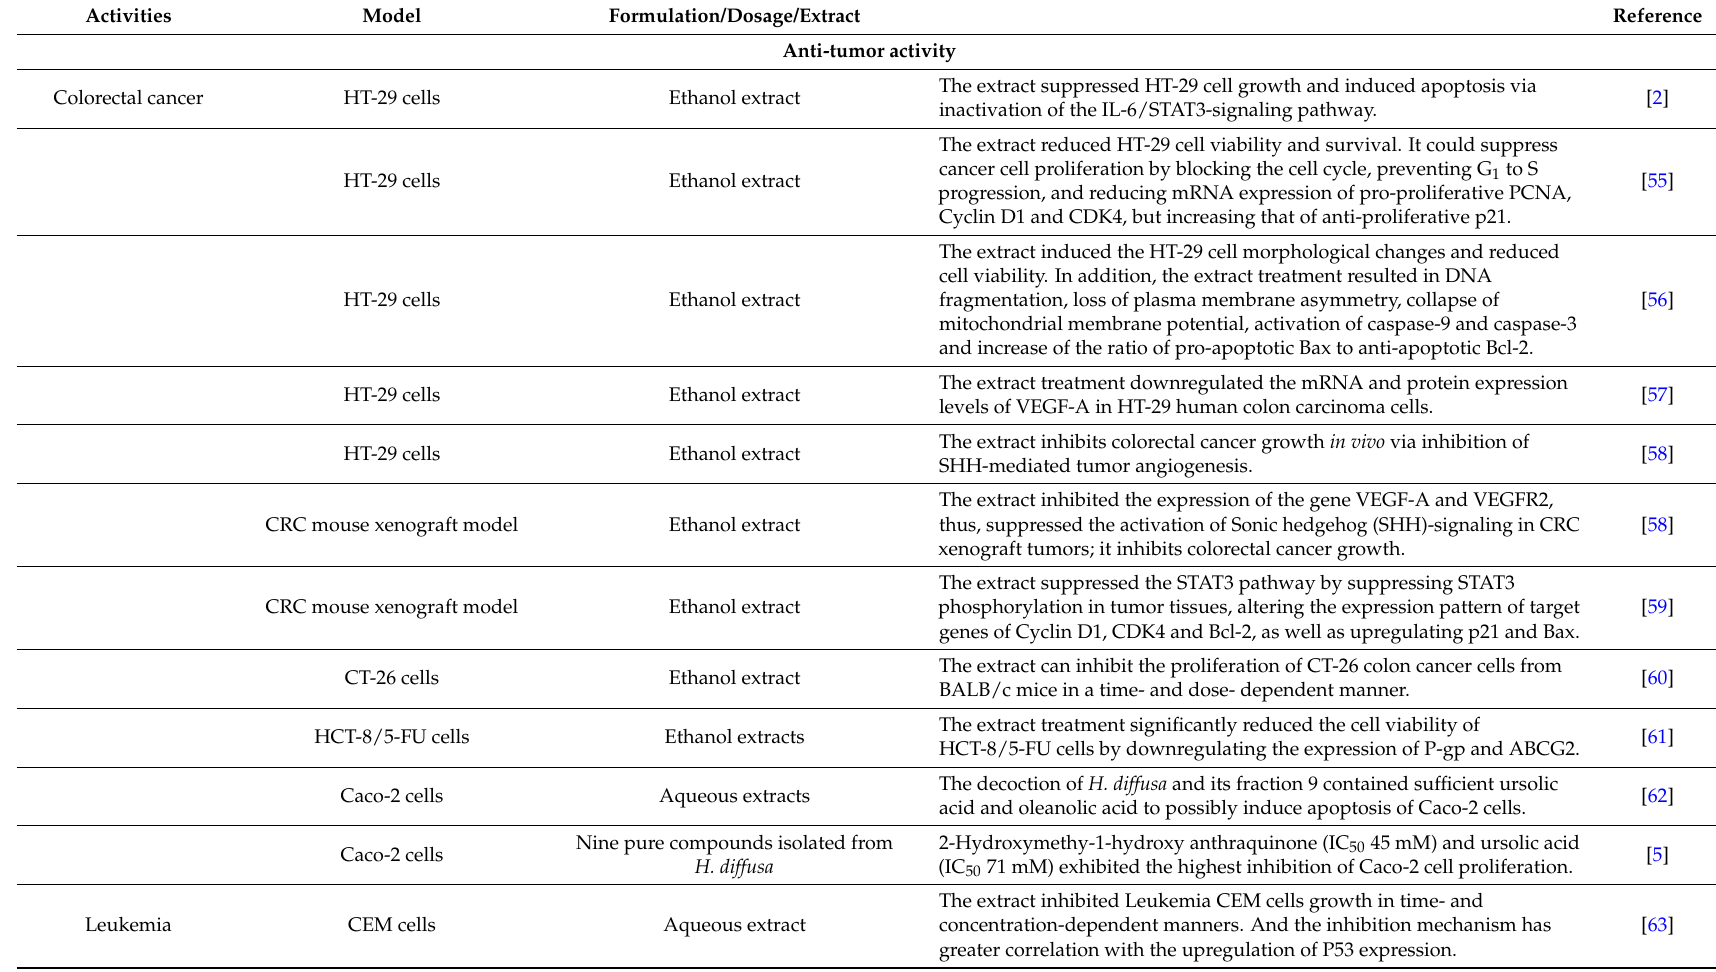
Table 2. Pharmacological effects of H. diffusa